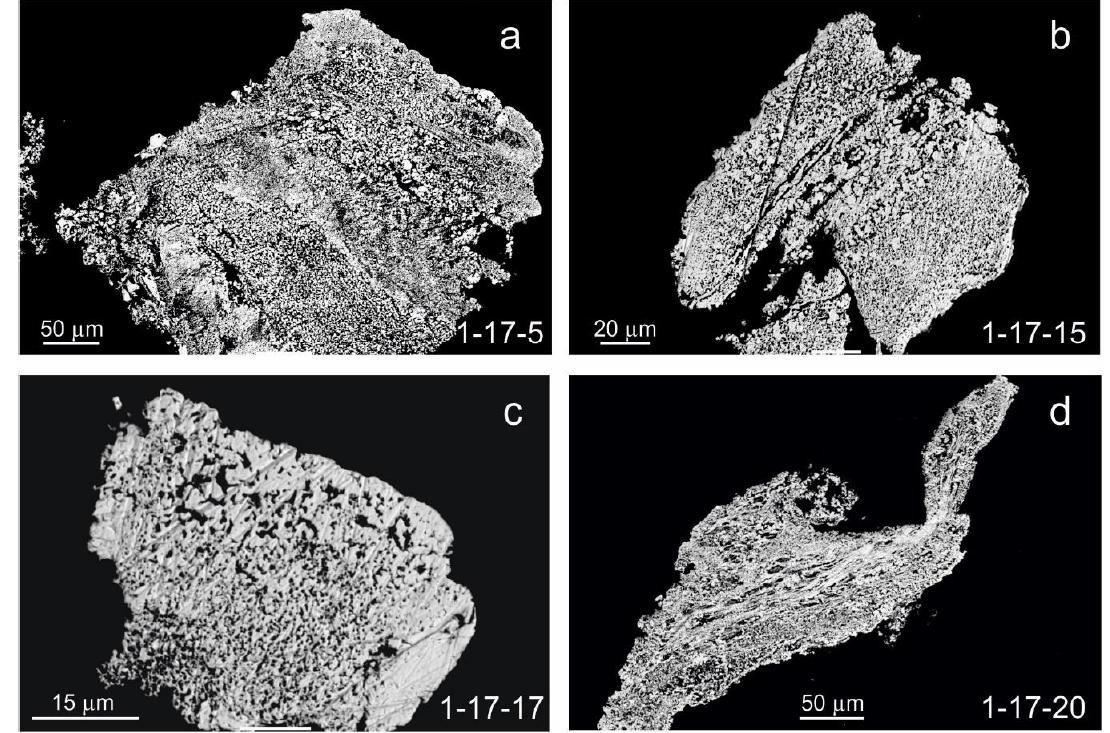
Figure 8. Mustard and sponge gold of microporous structure: ( a , b ) closely located mustard and sponge gold, ( c ) massive gold with spongy and mustard gold close the center, ( d ) microporous mustard gold with elongated fibers of massive gold in the center. Mounted sections, scanning electron microscope, image in the backscattering electron mode.